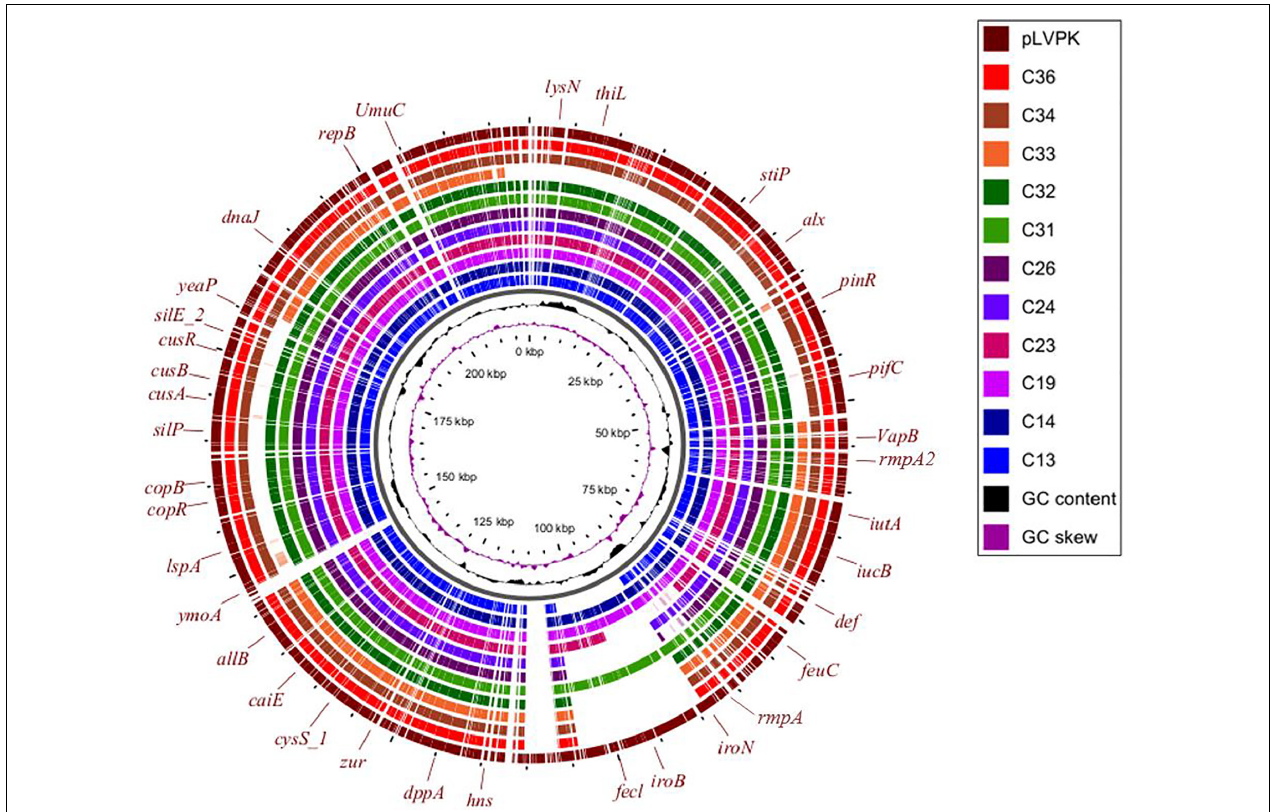
FIGURE 5 | Circular comparison between the classical virulence plasmid pLVPK and the assembled plasmid contigs based on Illumina short-read data of the other 11 CRKP strains in this